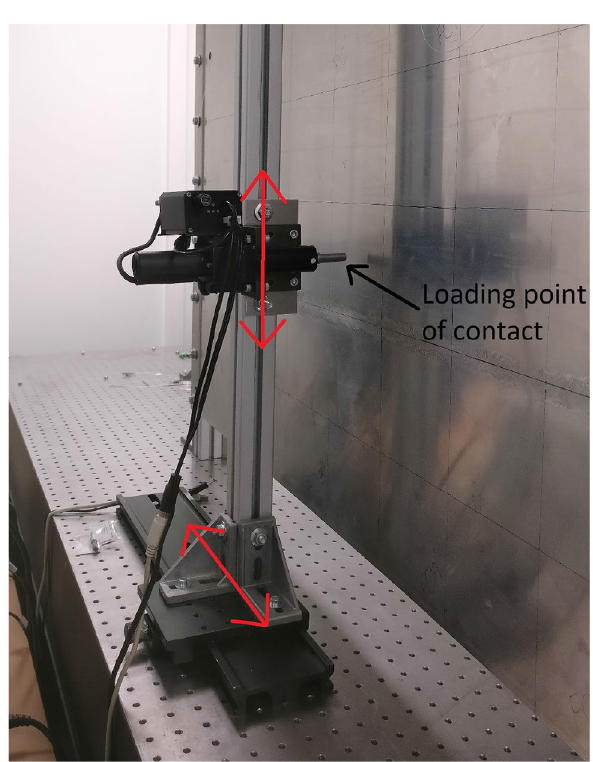
Fig. 7 Loading setup showing the vertical and horizontal slider mechanism for the linear